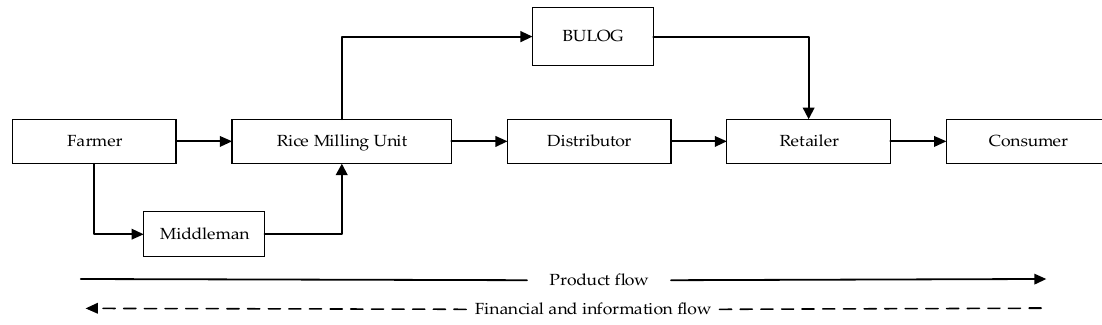
Figure 1. Rice supply chain in West Java Province.